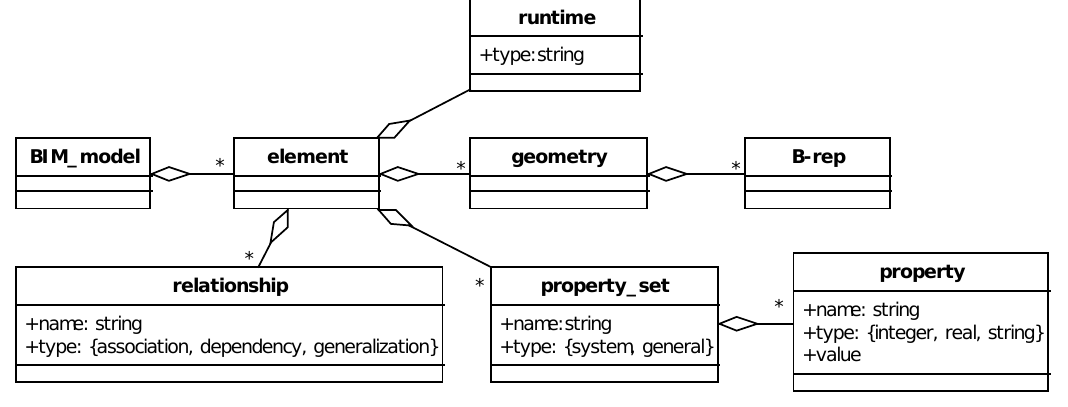
Figure 8. BIM DB conceptual model.